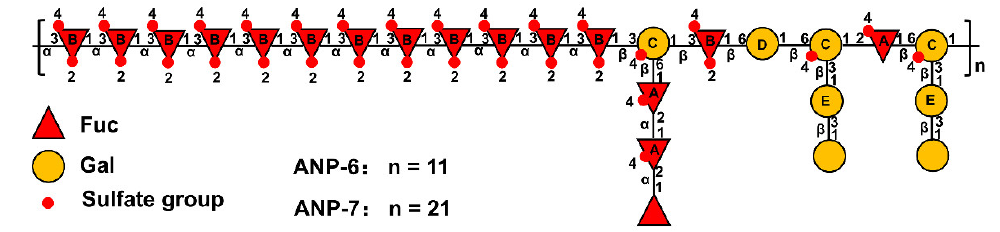
Figure 4. TOCSY spectra of ANP-6 ( A ) and ANP-7 ( B ) and NOESY spectra of ANP-6 ( C ) and ANP-7 ( D ).